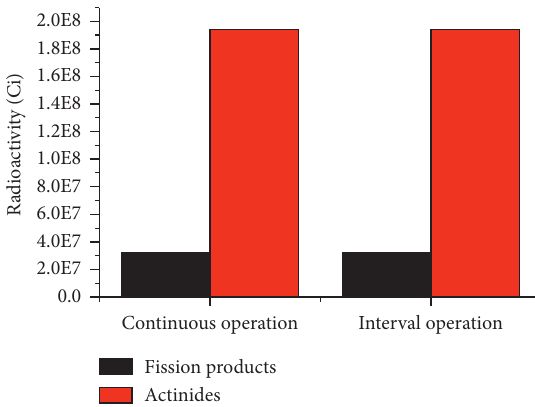
Figure 7: The radioactivity of actinides and fission products under different operation